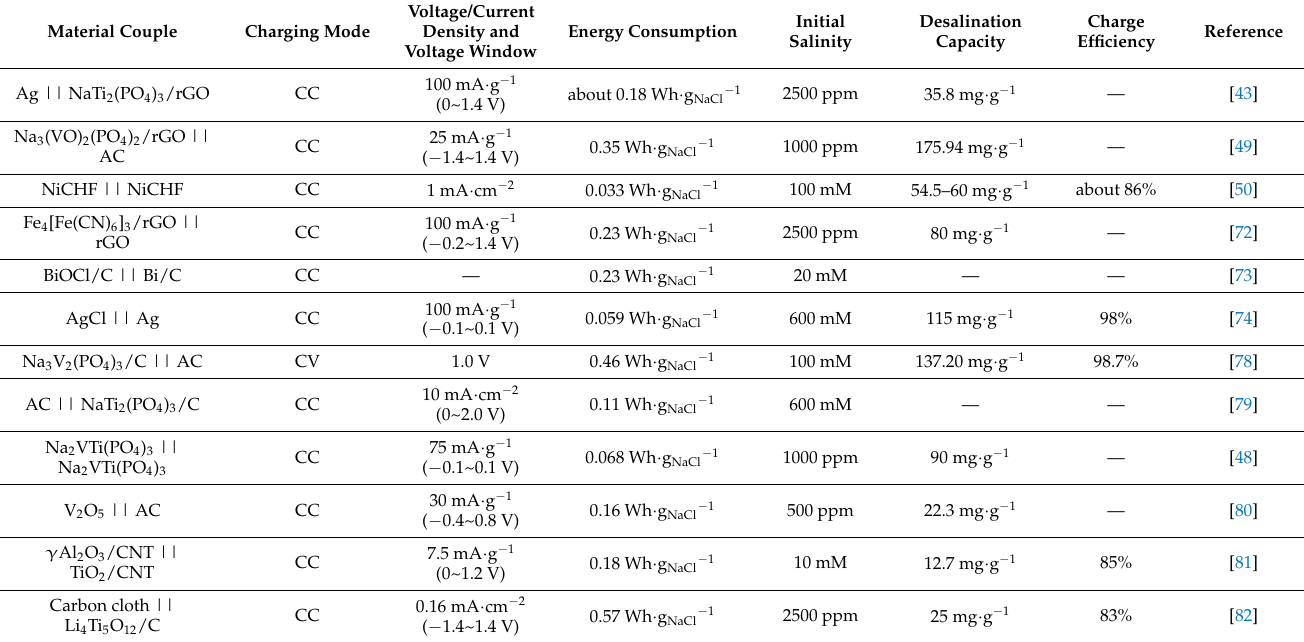
Table 1. Energy consumptions of battery materials of CDI in the